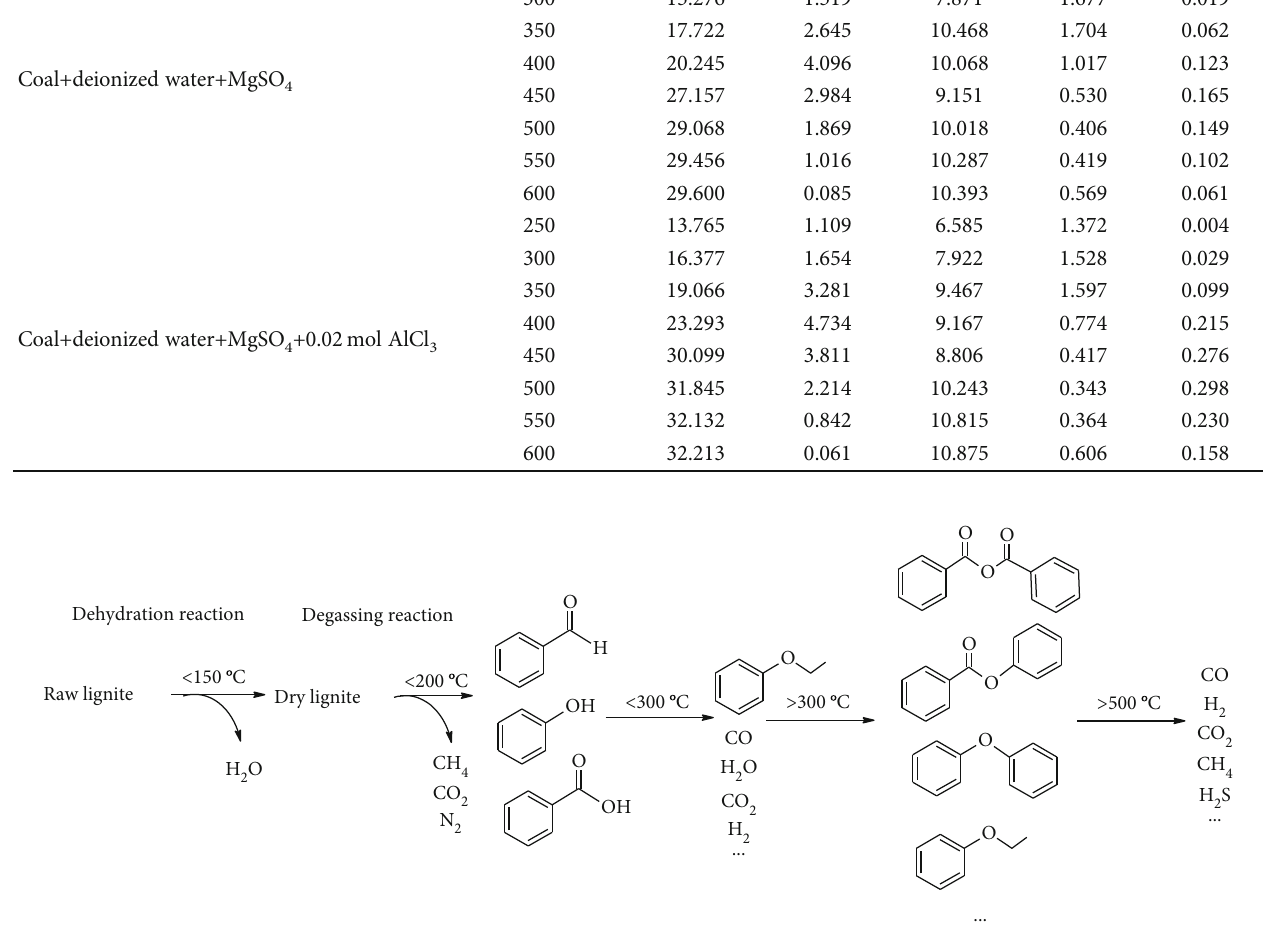
Figure 2: Reaction pathways for the briquette